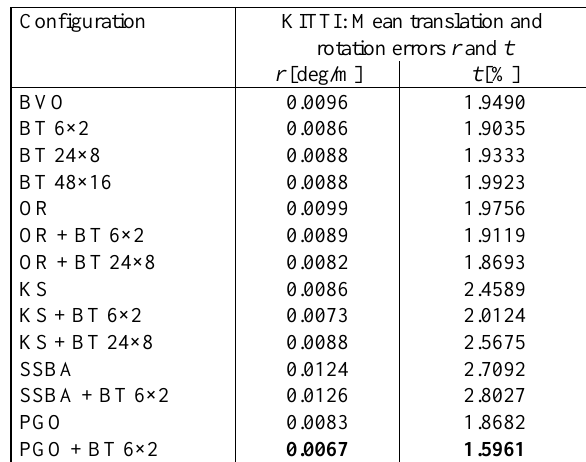
Table 2. Mean translation and rotation error rates for KITTI